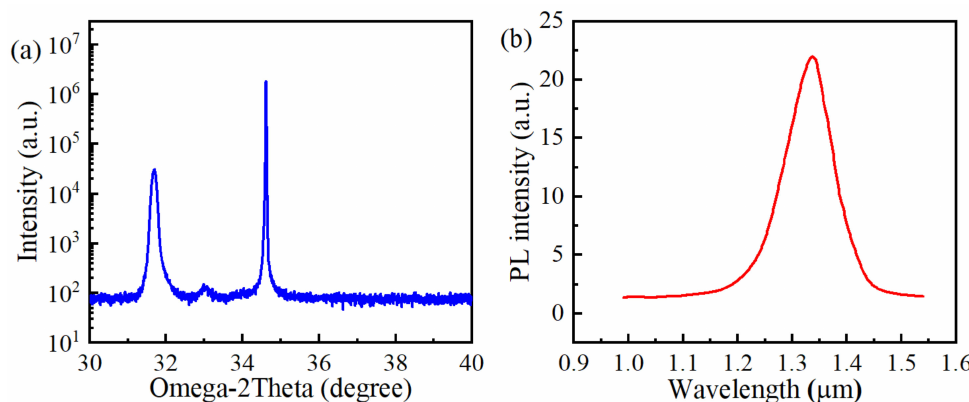
Figure 2. ( a ) HRXRD diffraction curves of InGaAsP matched to InP. ( b ) Room temperature µ -PL spectra of InGaAsP matched to